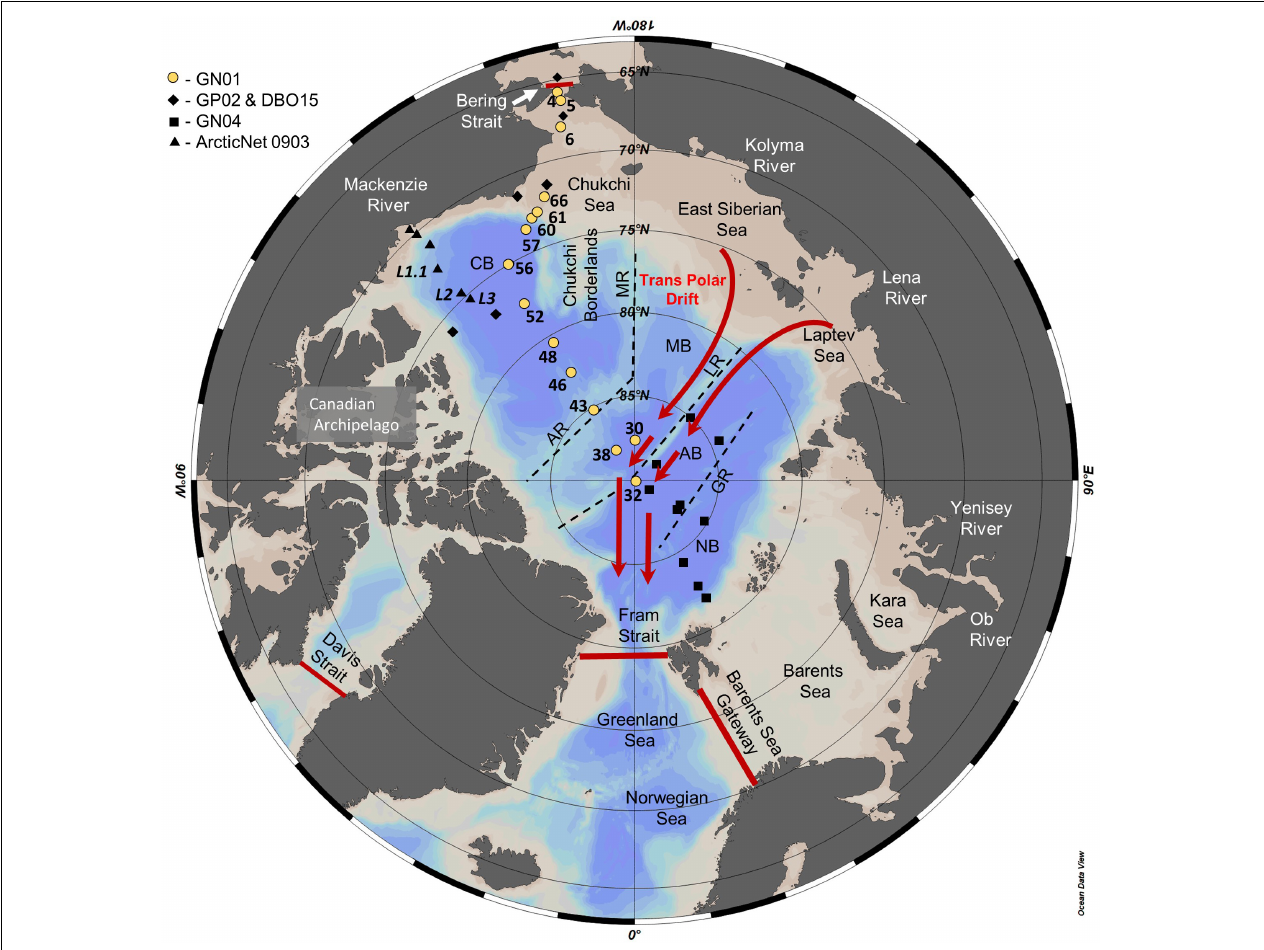
FIGURE 1 | Map of the Arctic Ocean showing the location of stations sampled during US GEOTRACES GN01, Canadian GEOTRACES GP02 and Canadian Distributed Biological Observatory cruise DBO15, German GEOTRACES GN04, and Canadian IPY-GEOTRACES (ArcticNet 0903). Red lines denote major exchange gateways of the Bering Strait, Davis Strait, Fram Strait, and Barents Sea used to determine the Arctic Ocean silicic acid budget (Torres-Valdés et al., 2013). Dotted lines approximate the position of the Alpha and Mendeleev Ridge (AR and MR) separating the Canada Basin (CB) and the Makarov Basin (MB), the Lomonosov Ridge (LR) separating the Makarov Basin and the Amundsen Basin (AB), and the Gakkel Ridge (GR) separating the Amundsen Basin and the Nansen Basin (NB). Red arrows indicate the approximate flow path of the transpolar drift (TPD).